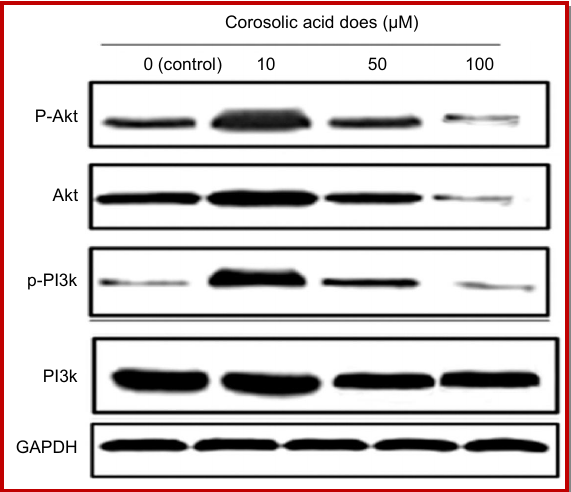
Figure 7: Corosolic acid targets PI3K/Akt signalling pathway in CaSki cervical cancer cells. Western blot assay was used to detect the changes in protein expressions. The cells were treated with 10, 50 and 100 µM dose of corosolic acid and it was seen that there was a down-regulation of PI3K/Akt pro- tein